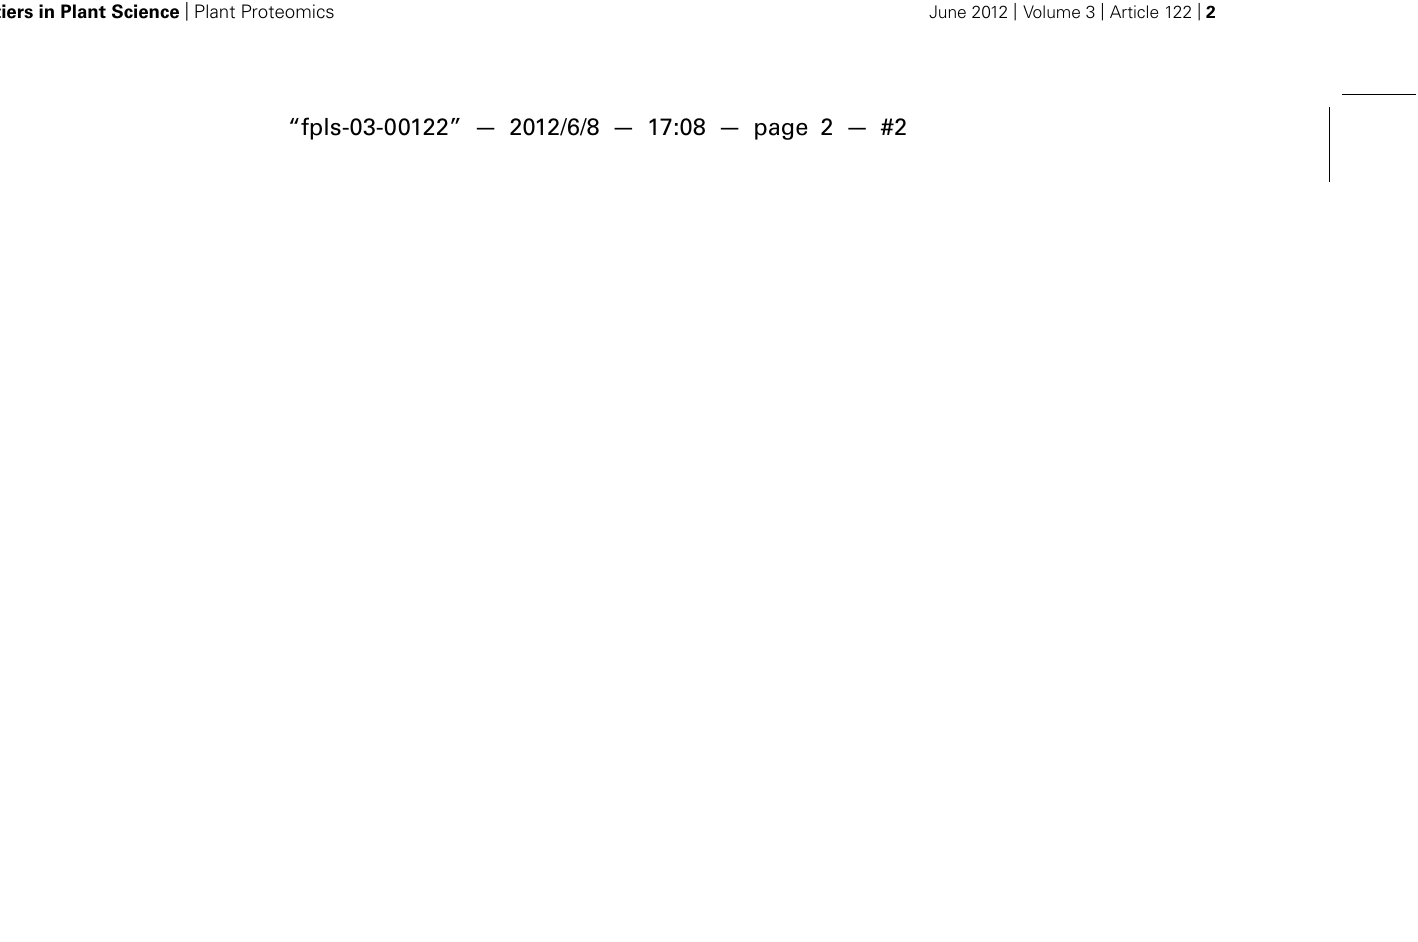
metal affinity chromatography (IMAC), and sampled using nHPLC- MS/MS. Peptides were fragmented via electron transfer dissociation (ETD) or collisionally activated dissociation (CAD).The results of this workflow are displayed in the table labeled phosphopeptide results. Modified from Grimsrud etal.